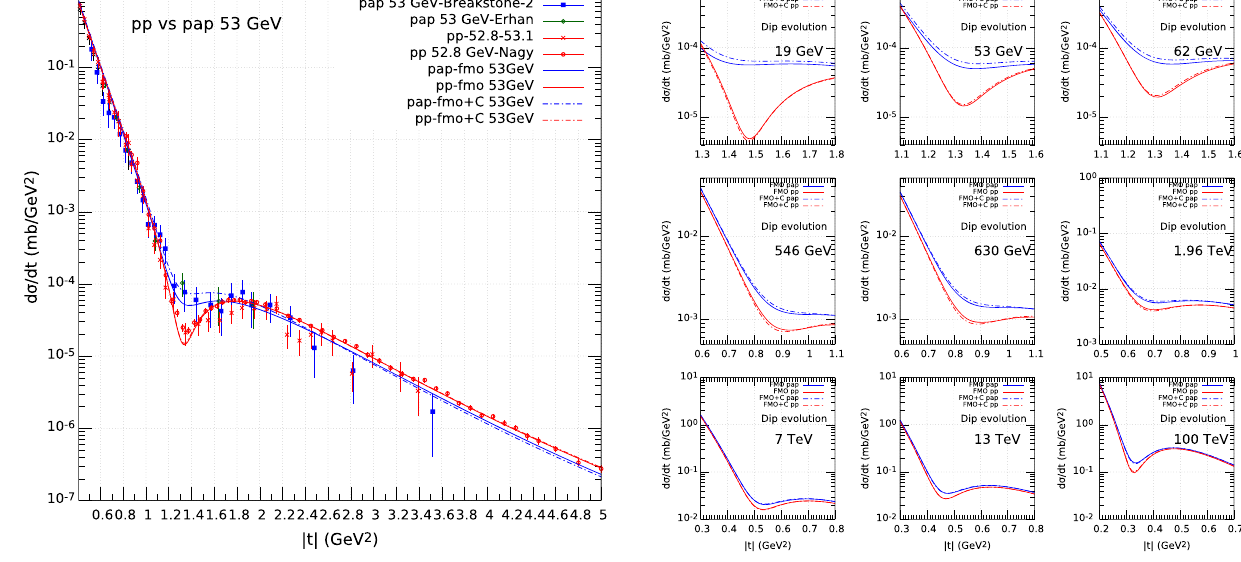
Fig. 8 pp and ¯ pp differential cross sections at